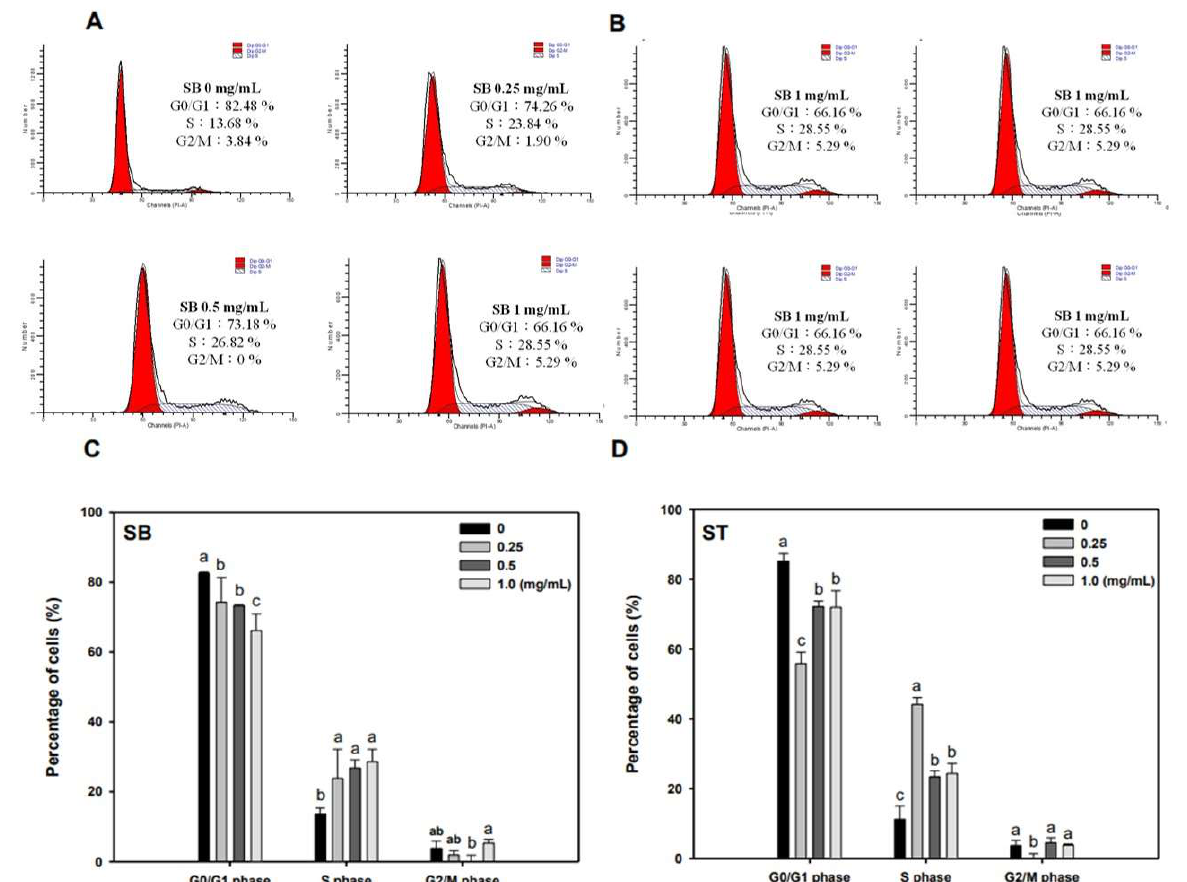
Figure 3. Effect of SB and ST on the cell cycle progression of HSC-3. ( A , B ) After the treatment of SB and ST at various concentrations for 72 h, HSC-3 cells were harvested, stained with propidium iodide, and analyzed by flow cytometry. Flow cytometric histograms are representative of three separate experiments. ( C , D ) Quantification of the percentage of HSC-3 cells treated by SB and ST in the cell cycle. Bars represent standard deviations from triplicate determinations. Different letters indicate significant differences ( p < 0.05).